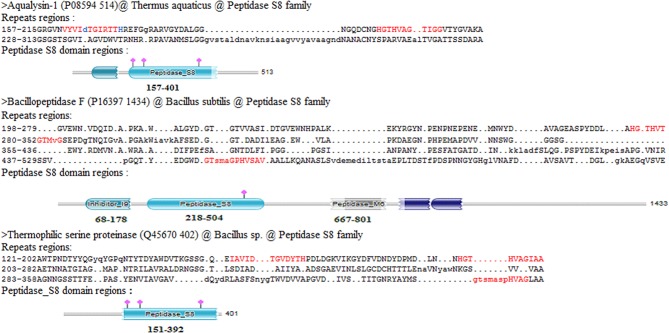
The Aqualysin-1(P085594), Bacillopeptidase F(P16397), and Thermophilic serine proteinase (Q45670) protein's repeats regions and their alignments that are in the Peptidase S8 domain region assigned by Pfam.